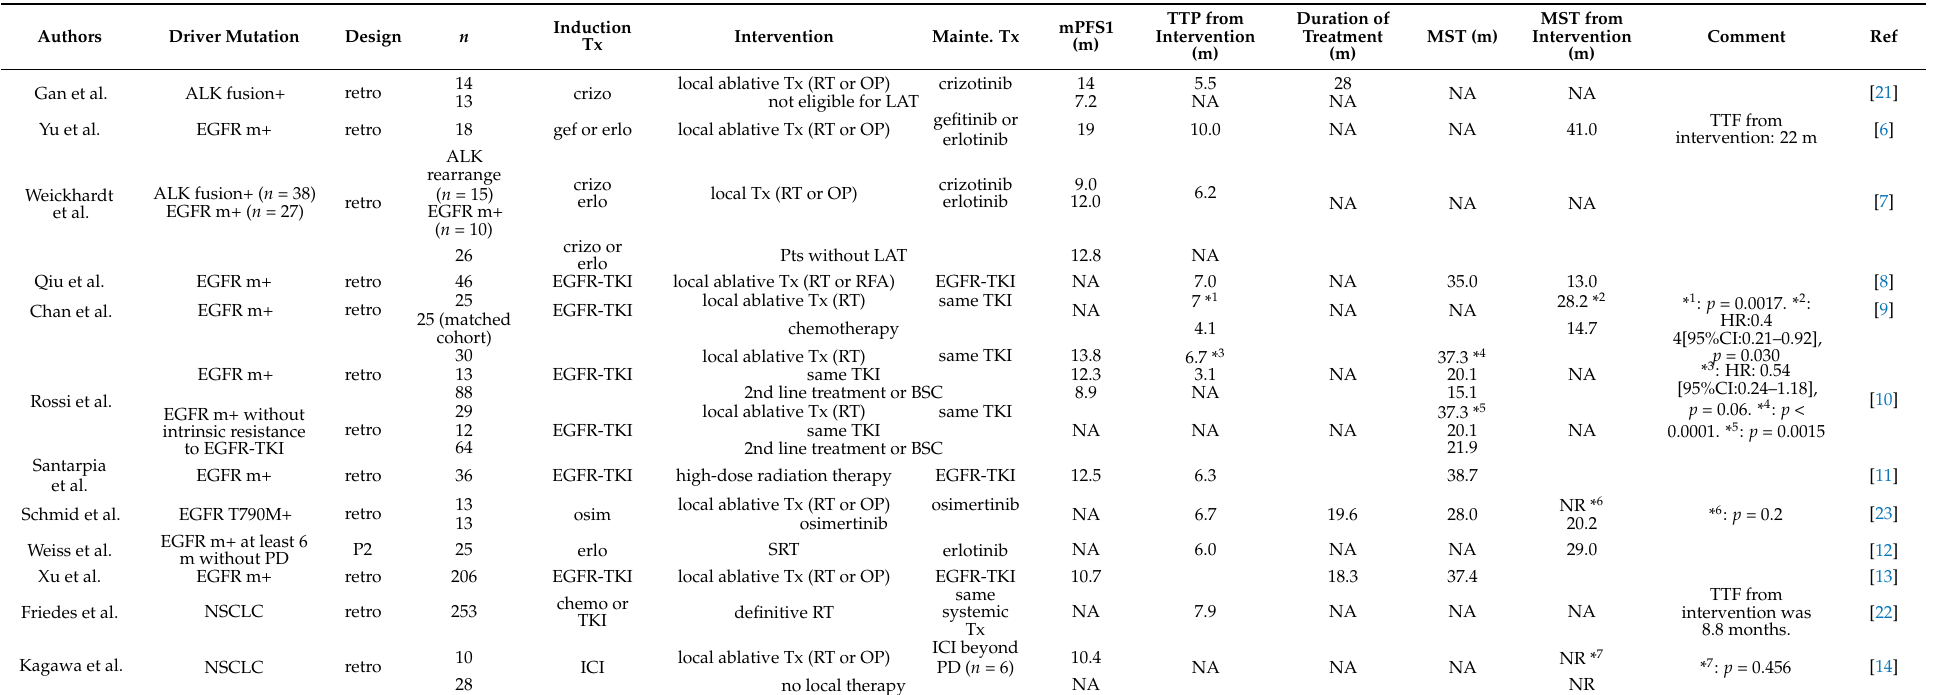
Table 2. Outcomes of local ablative therapy for oligoprogressive